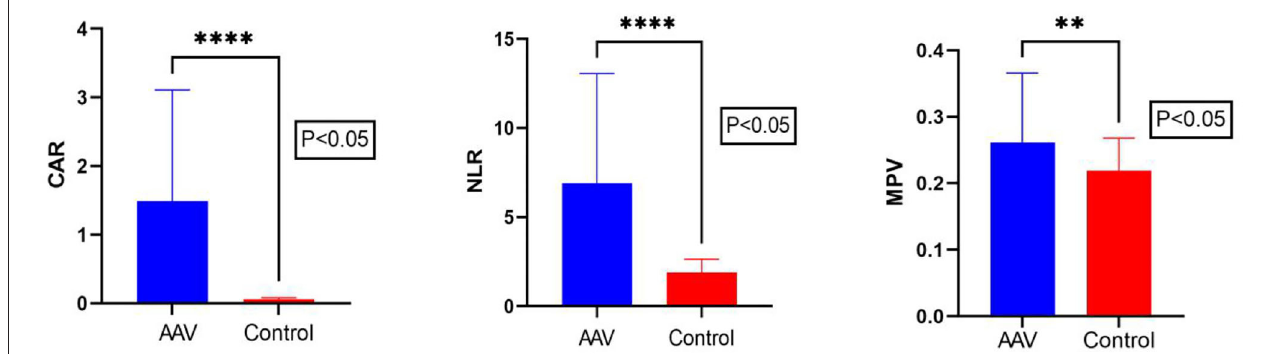
FIGURE 1 | Comparison of CAR, NLR, and MPV levels between AAV patients and the control group. The Mann–Whitney U test showed that the CAR, NLR, and MPV levels in AAV patients were significantly higher than in the control group. CAR, C-reactive protein/albumin ratio; NLR, neutrophil/lymphocyte ratio; MPV, mean platelet volume. The ****symbol indicates p < 0.0001 and ** symbol indicates p < 0.01.